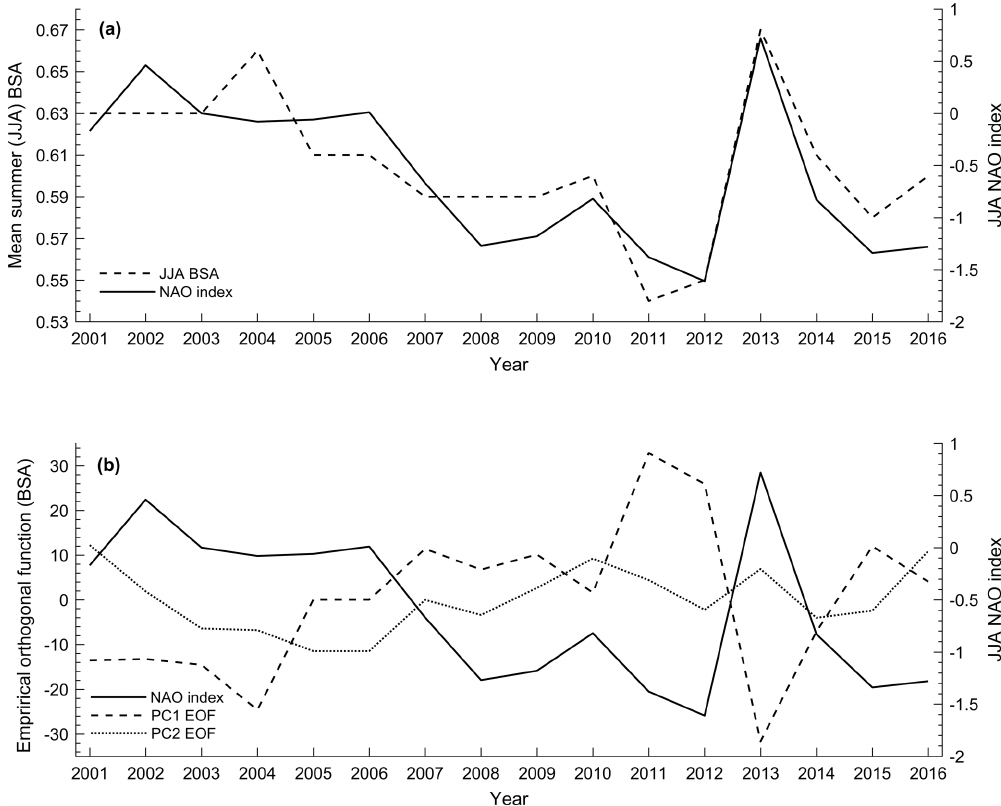
Figure 9. (a) mean summer (JJA) clear-sky shortwave broadband black-sky albedo (left-hand axis) and the mean summer (JJA) NAO index (right-hand axis) for 2001–2016. (b) Empirical orthogonal functions (EOFs) for the first and second principal components of the 16-year